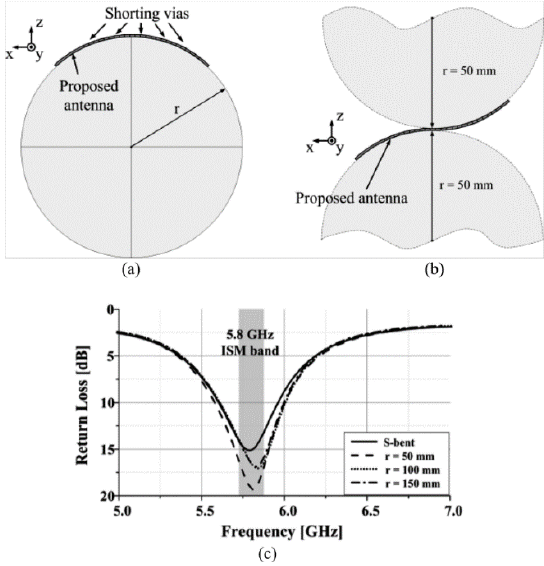
Figure 21. Antenna bending simulation. ( a ) Bending setup. ( b ) S-bending setup. ( c ) Return loss characteristics [235].